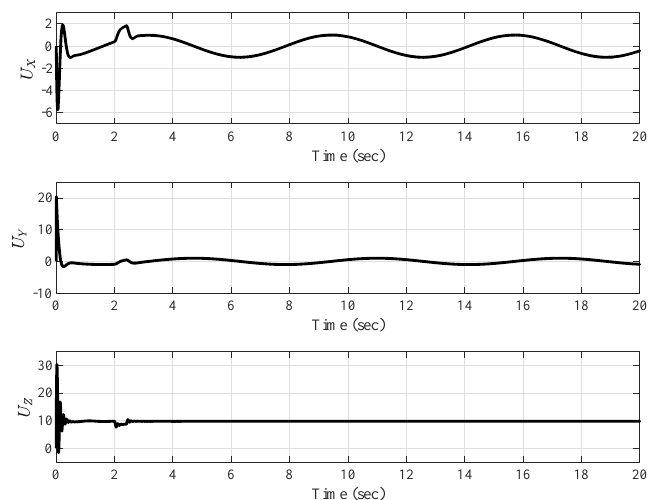
Figure 12. Control signals U 1 to U 4 .